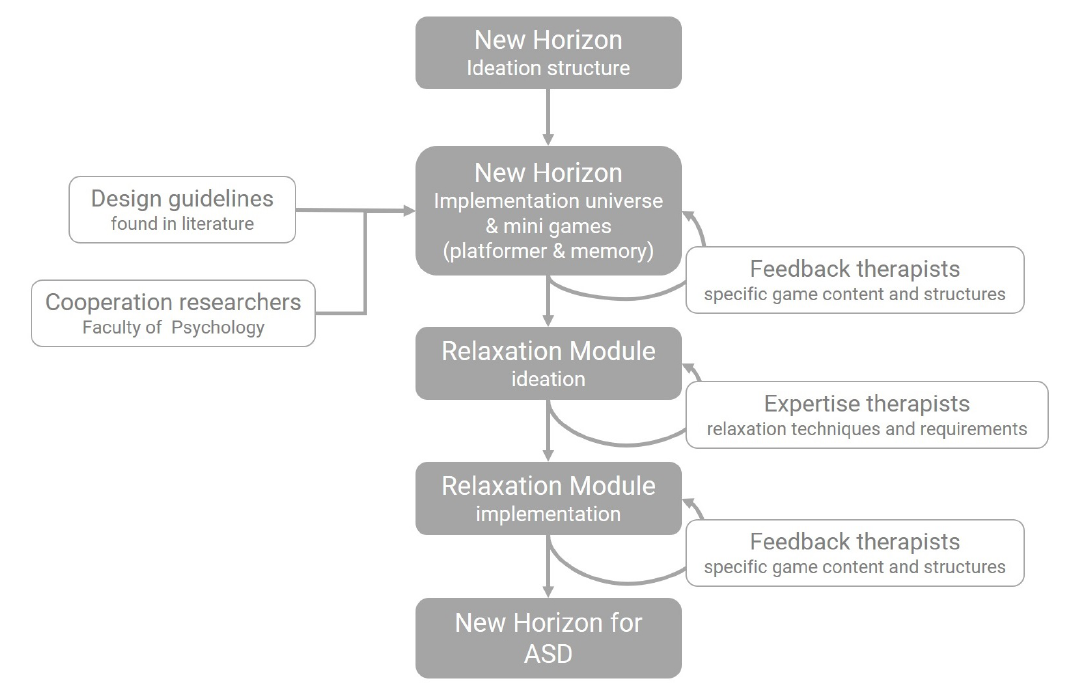
Figure 4. Design flow